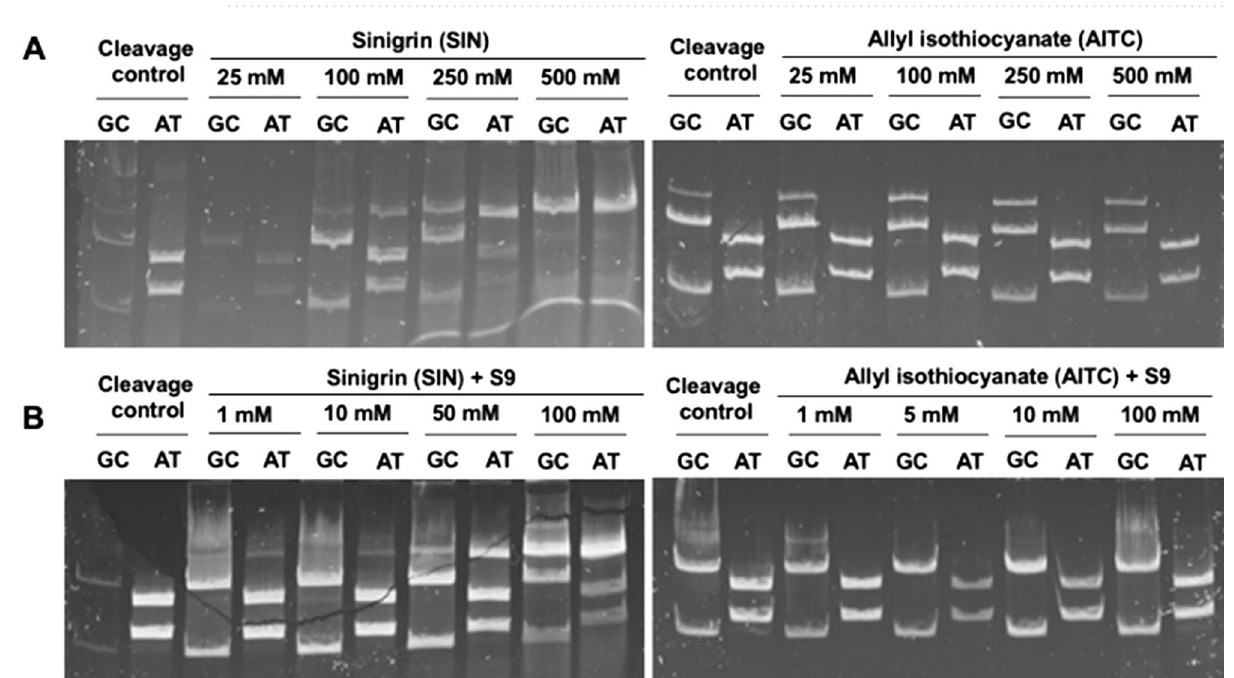
Figure 7. DNA fragments generated as a result of endonucleolytic cleavage of DNA amplicon with HpaII (GC-specific) or Tru1I (AT-specific) enzymes. ( A ) DNA amplicon incubated for 2 h at 37 °C with increasing sinigrin (SIN) or allyl isothiocyanate (AITC) concentrations before restriction analysis was performed as described in the “Materials and methods” section. As control served DNA amplicon incubated with water or DMSO in place of the tested compounds. ( B ) SIN and AITC were pre-incubated for 15 min at 37 °C with an S9 mixture for the metabolic activation of tested compounds. Then DNA amplicon was added to each sample and incubated for 30 min at 37 °C and restriction analysis was performed as described in the “Materials and methods” section. DNA amplicon incubated with water or DMSO in place of the test compound solution served as